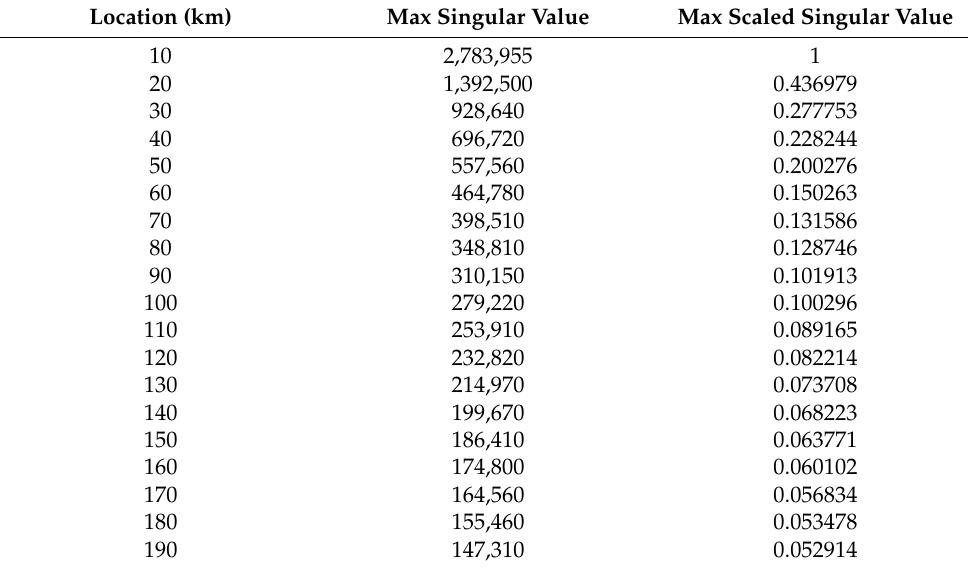
Table A9. The maximum singular and its scaled values for LL fault at 19